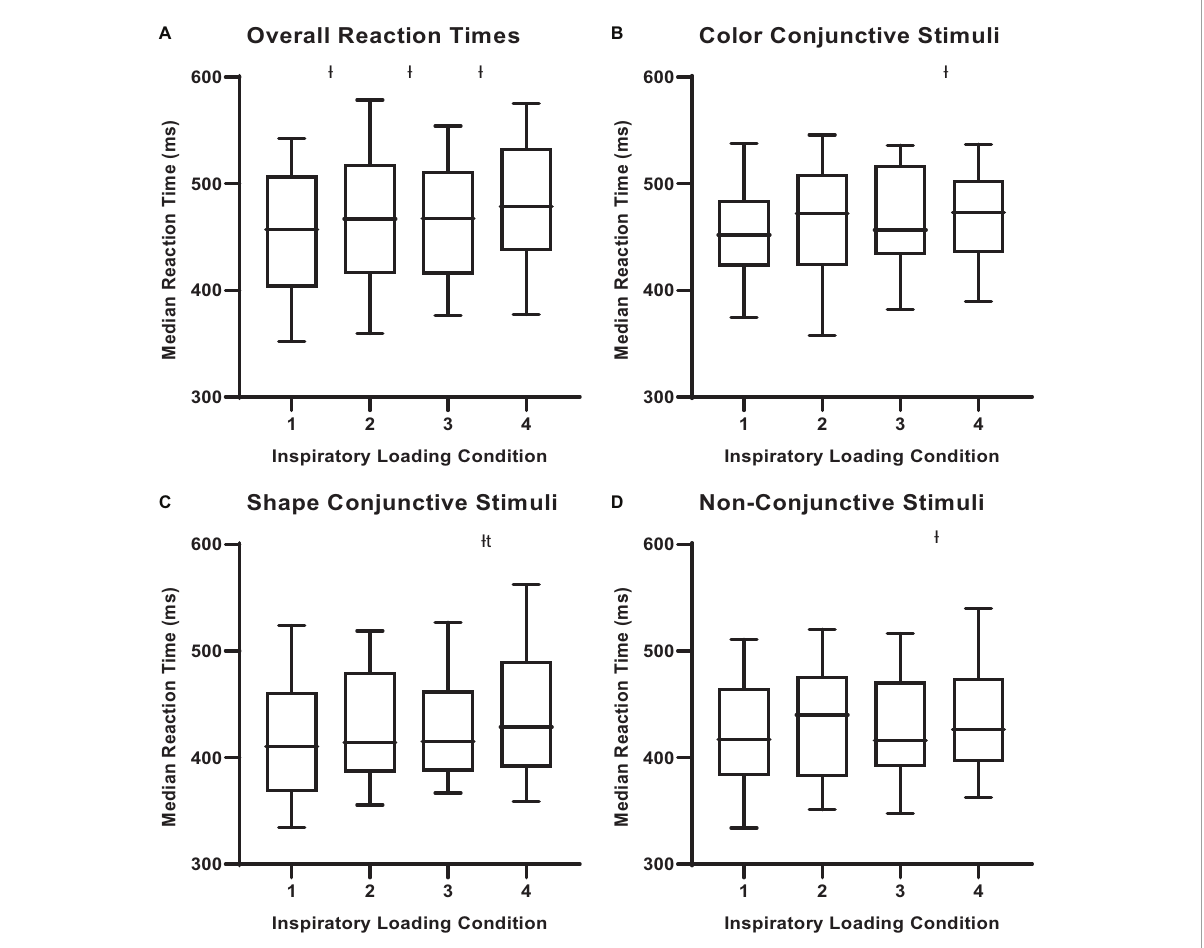
FIGURE4 Median reactions times for different stimuli across inspiratory threshold loading conditions during masked conjunctive continuous performance trials. (A) Depicts the differences in overall median reaction times across loading conditions. (B) Depicts the differences in median reaction times for color conjunctive stimuli across loading conditions. (C) Depicts the differences in Median Reaction Times for shape conjunctive stimuli across loading conditions. (D) Depicts the differences in median reaction times for non-conjunctive stimuli across loading conditions. The upper and lower limits of the box represent the 95% CI, the horizontal line in the box represents the median, and the whiskers represent the SEM. I Significant difference from load condition 1, P < 0.05. t Significant difference from load condition 2, P < 0.05.